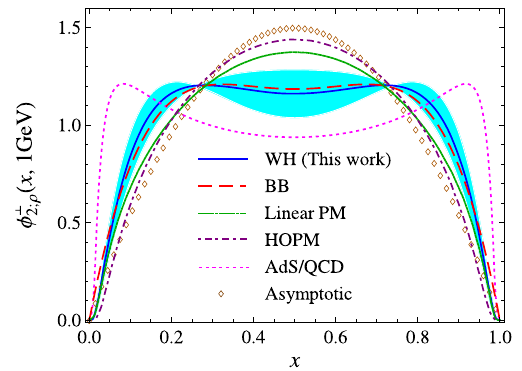
( x ,μ = 1 GeV ) pre- 0 2 ; ρ